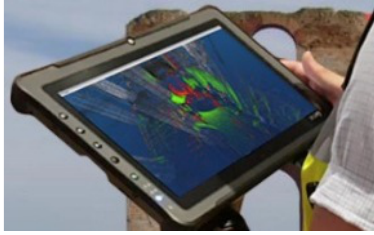
Figure 9 Updated 3D mesh model (courtesy of Gexcel)